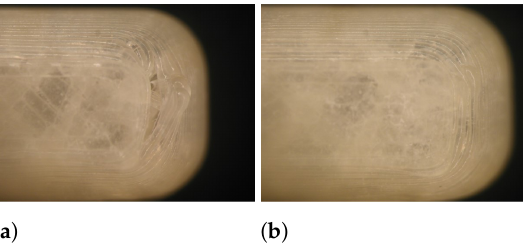
Figure 12. The influence of overlap on the visual quality of the resulting caplet: 10% ( a ), 50% ( b ). Reproduced from [24], MDPI, 2021.